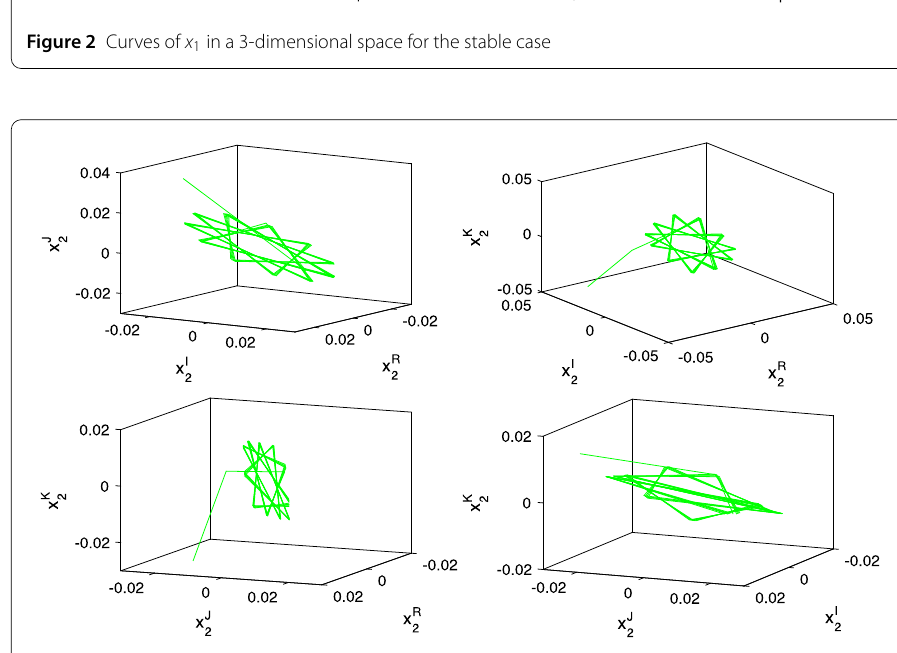
Figure 3 Curves of x 2 in a 3-dimensional space for the stable